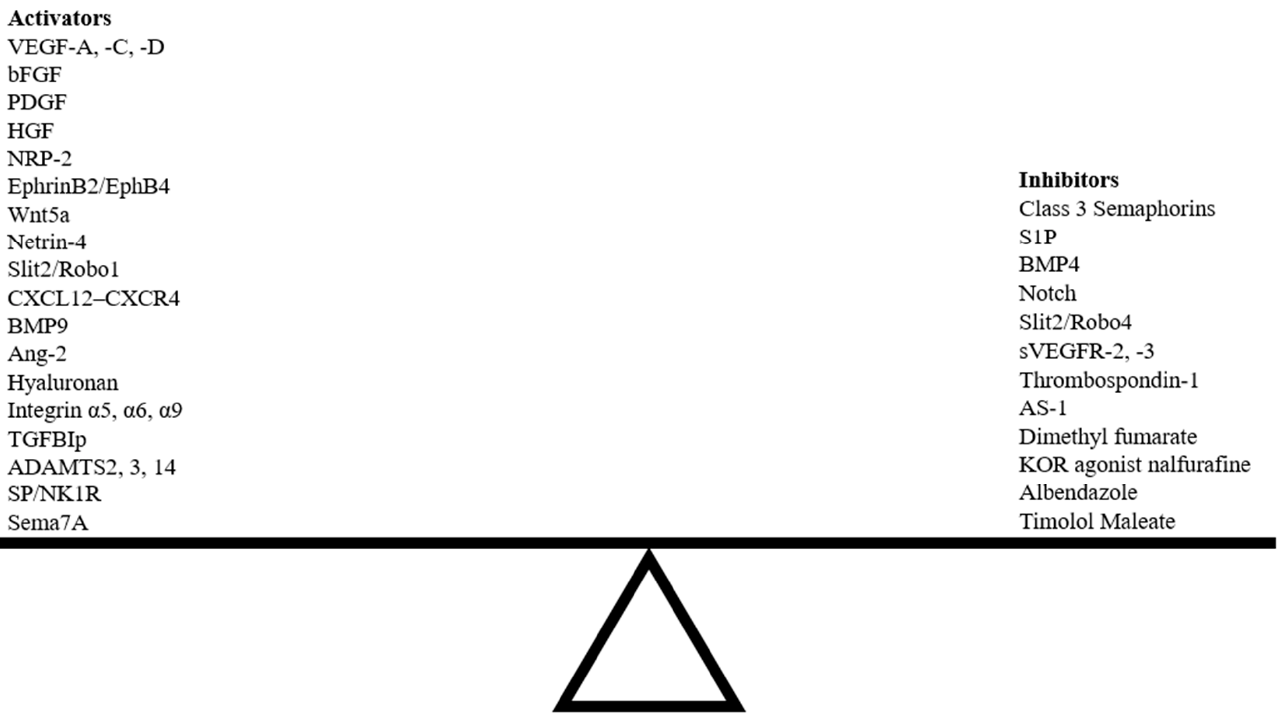
Figure 6. Balance between activators and inhibitors of corneal lymphangiogenesis guidance pathways. Abbreviations; HGF, hepatocyte growth factor; ADAMTS, a disintegrin and metalloproteinase with